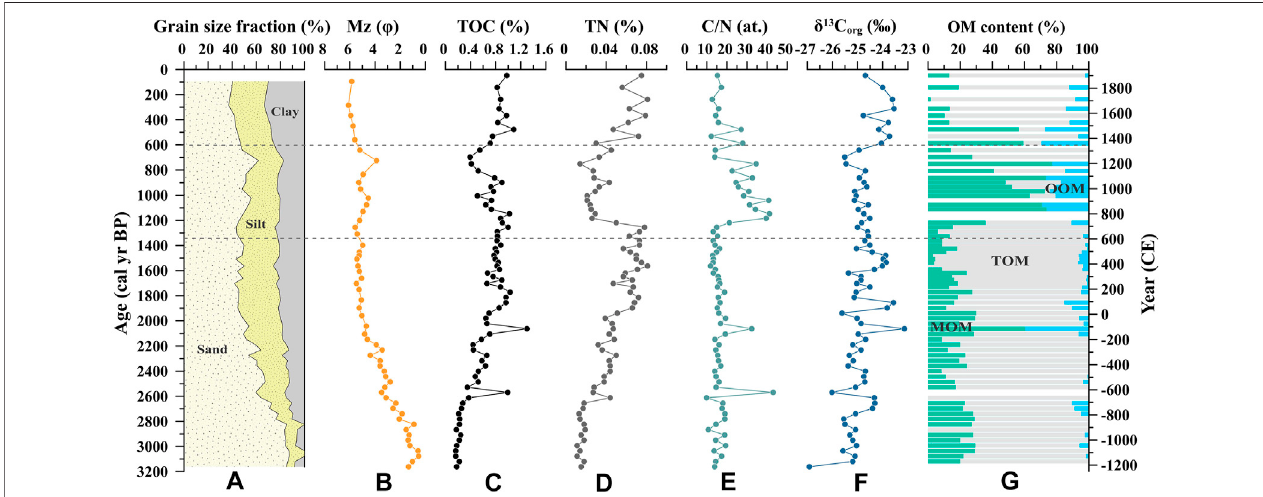
FIGURE4| Scatterdiagramsof δ 13 C org vs.C/Nfor (A) endmembersoforganicmatter(OM)sourcesand (B) coreQ43sampleswiththeternarymixingmodel.Theshadow areasin (A) representtherangesofmangrove,terrestrial(Xiaetal.,2015;Mengetal.,2016b),andoceanicendmembers(Xueetal.,2009;Xiaetal.,2015;Qiu,unpublisheddata). The error bars show the standard deviation of the endmember values. The pink empty circles in (B) are endmember values with the tolerance interval expanded by 25%.